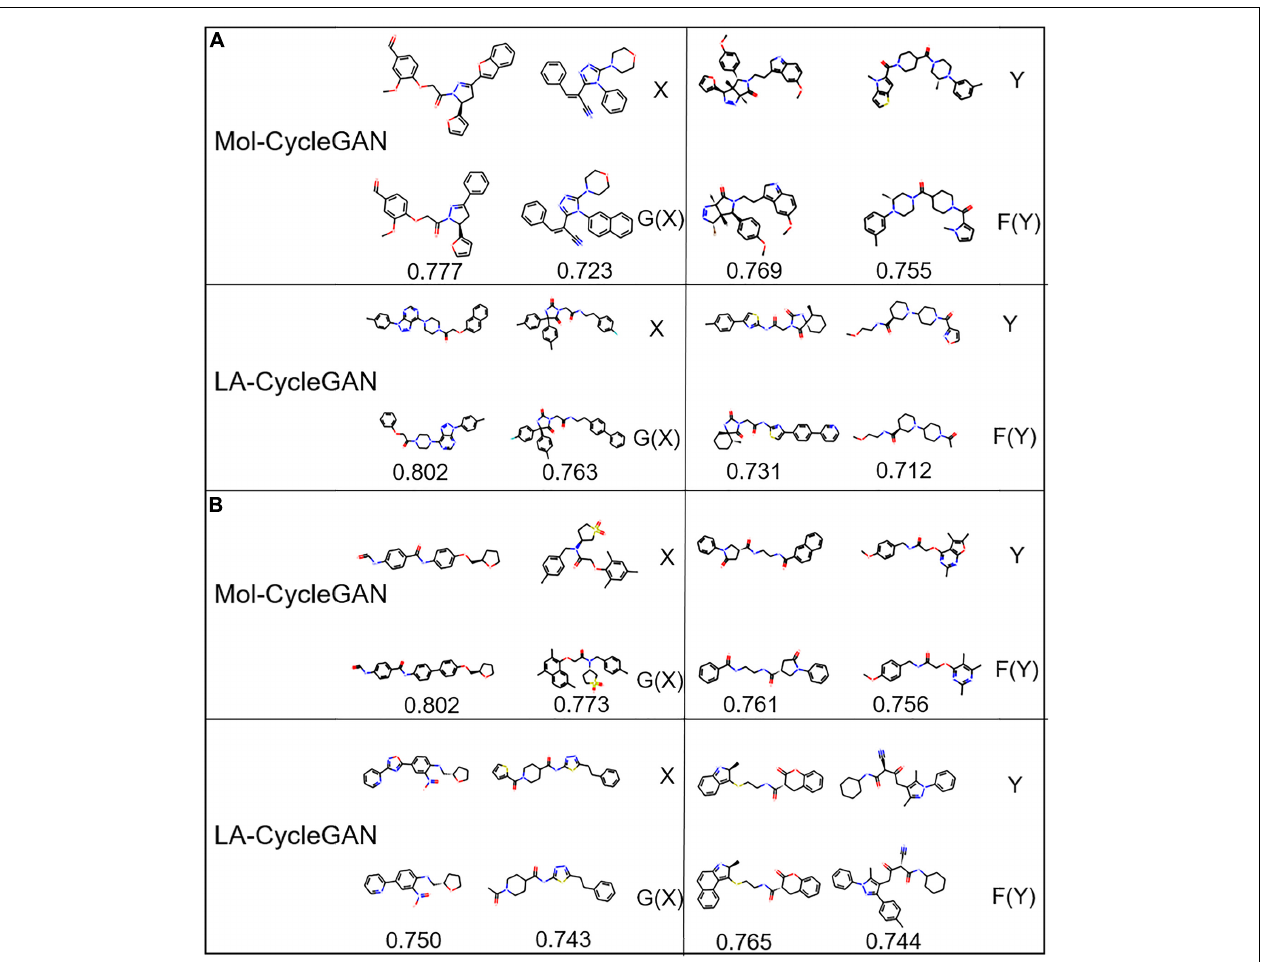
FIGURE 7 | Molecular structure diagram. (A) Molecules from the aliphatic ring subset; (B) molecules from aromatic ring subset. In each sub-figure, the upper layer shows the starting molecules, the middle layer shows the generated molecules, and the bottom layer shows the similarity score.